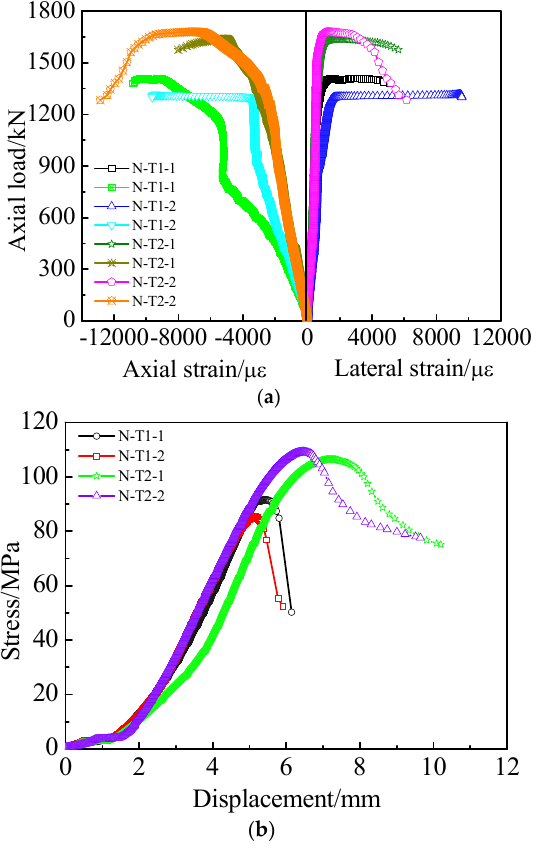
Figure 4. ( a ) The relationships between load and axial/lateral strains of the SCCFTST columns; ( b ) the relationships between stress and displacement of the SCCFTST columns.